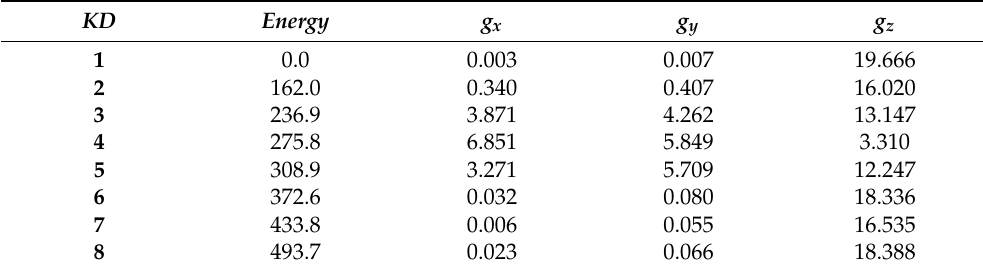
Table 2. The ab initio calculated energy levels (cm –1 ) and associated g -tensors of the eight lowest KDs for Dy ion in 1 .